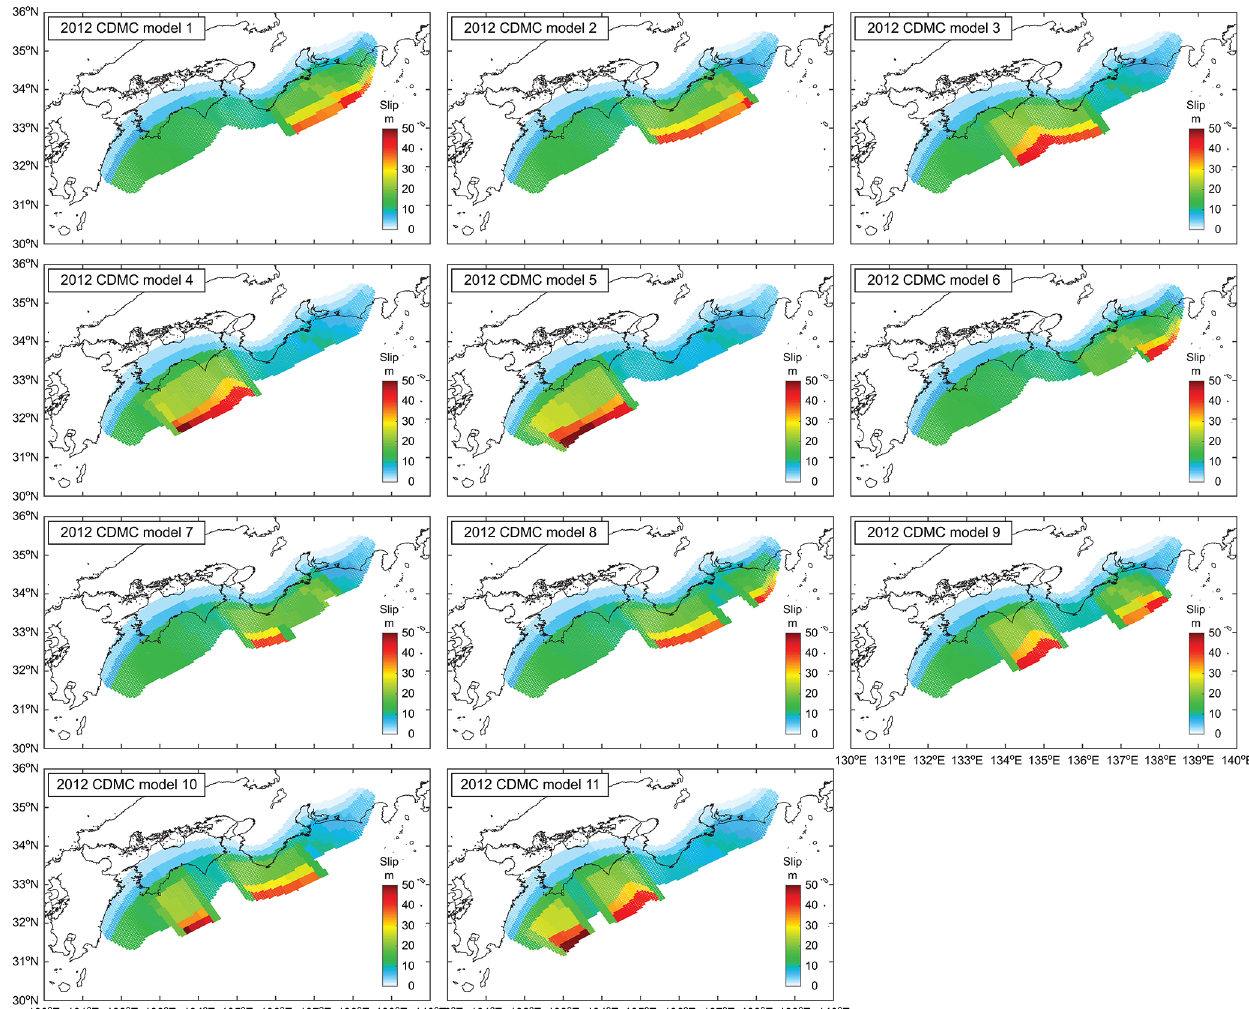
Figure 2. The 2012 Central Disaster Management Council tsunami source